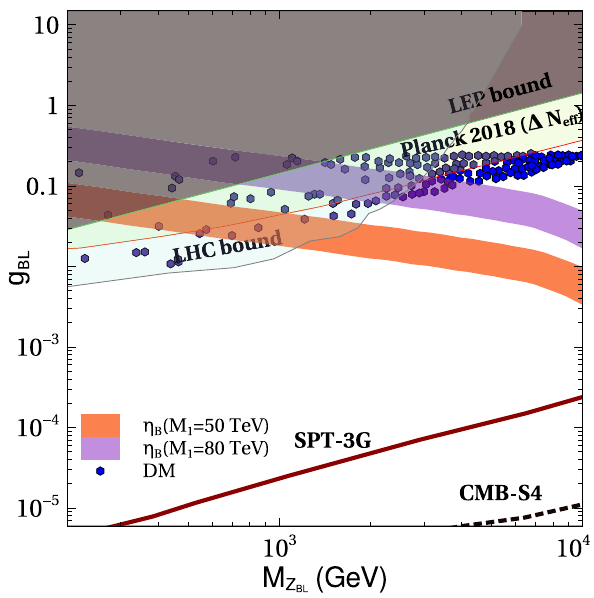
Fig. 8 Summaryplotshowingallowedparameterspacein g BL − M Z plane. In addition to the parameter space shown already in Fig. 7, the allowed points from DM phenomenology are indicated by blue dots. The Yukawa couplings chosen for this scan are ( Y η ) α 1 = 10 − 5 ( 1 + i ) and ( Y η ) α 2 = 3 × 10 − 1 ( 1 . 1 − i